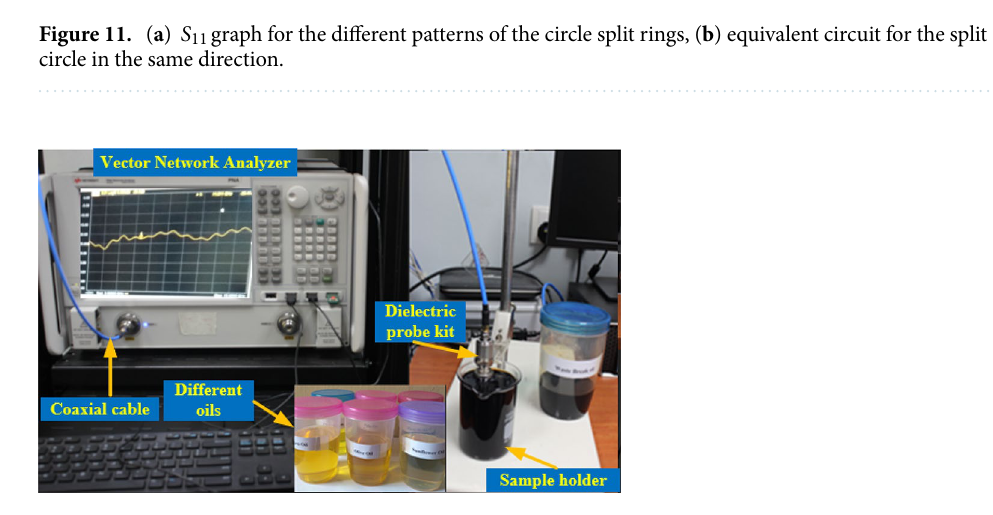
Figure 12. Measurement setup for the DK and LT of different samples using the N1500A dielectric probe